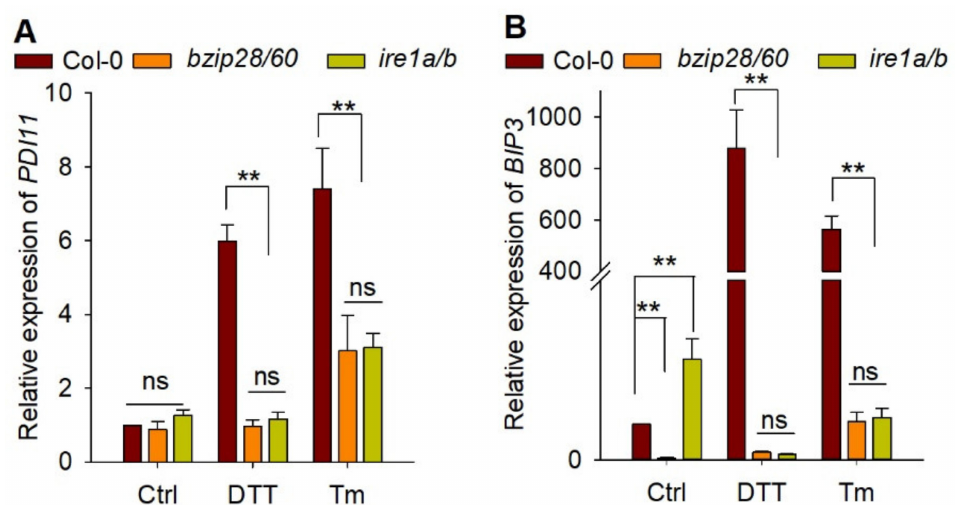
Figure 5. Quantitative real-time PCR analysis of AtPDI11 expression in wild-type Col-0, bzip28/60 , and ire1a/b mutants. Seven-day-old Col-0 and mutant seedlings were treated with or without 2 mM DTT or 5 µ g/mL Tm for 5 h. The expression levels of AtPDI11 ( A ) and AtBIP3 ( B ) were normal- ized to the expression level of AtGAPC . Values are shown as means ± SE from three independent biology repeats. Statistical significance compared with Col-0 was analyzed using one-way